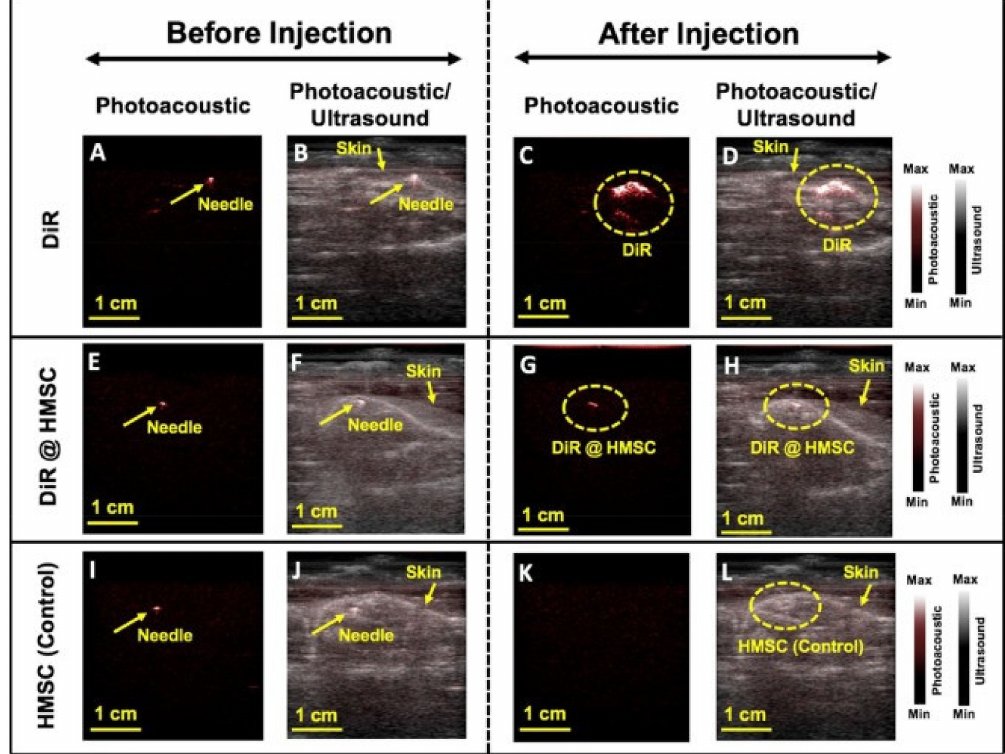
Figure 10. Images were separated in three groups: injecting DiR ( A – D ), DiR + HMSC ( E – H ), and HMSC ( I – L ). Each group contains PA and overlaid PA-US images before and after injection. Needles marked in images are subcutaneously injected on spinal cord area before DiR injection. The needle has a strong PA signal. Reprinted from Ref.